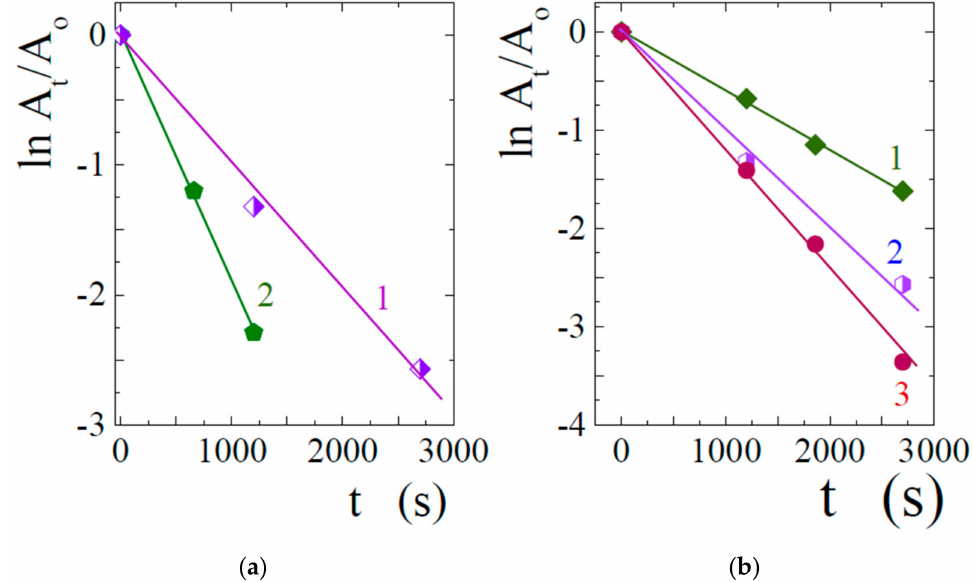
Figure 9. Time-dependent changes of the normalized optical absorbances at 400 nm (Figure 7). The stock solutions contained 0.5 mM 4-nitrophenol and 10 mM NaBH 4 . Bionanocomposites were prepared by dipping TA@SiO 2 containing 0.1 wt.% TA into a 10 мл solution with ( a ) 0.2 mM AgNO 3 (line 1) and 0.2 mM HAuCl 4 (line 2); ( b ) 0.4 (line 1), 0.2 (line 2) and 0.1 (line 3) mM AgNO 3